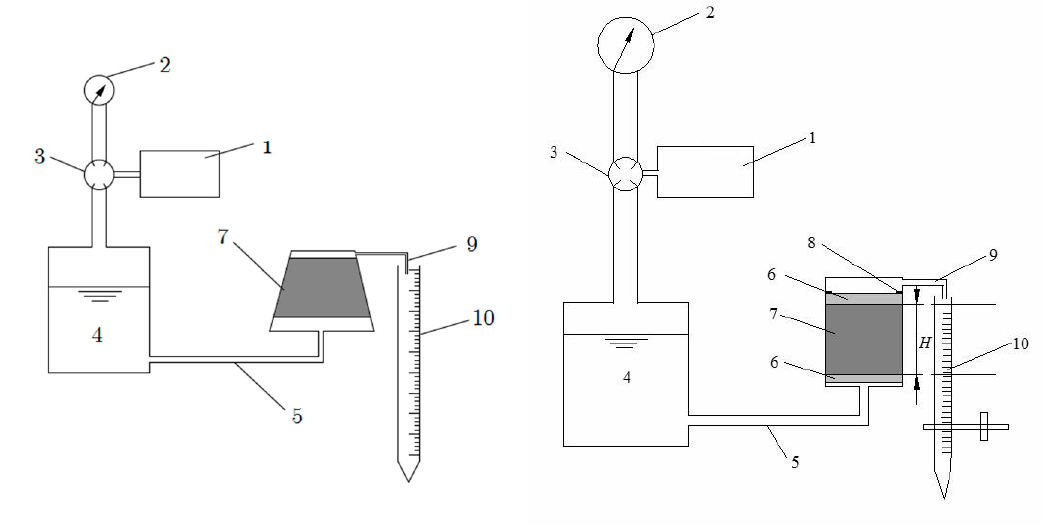
Figure 2. The modified permeability testing apparatus. 1: Air bump; 2: Pressure gage; 3: Pressure regulating valve; 4: Flume; 5: Water inlet; 6: Porous stone; 7: Soil-cement specimen; 8: Steel flake; 9: Water outlet; and 10: Burette.